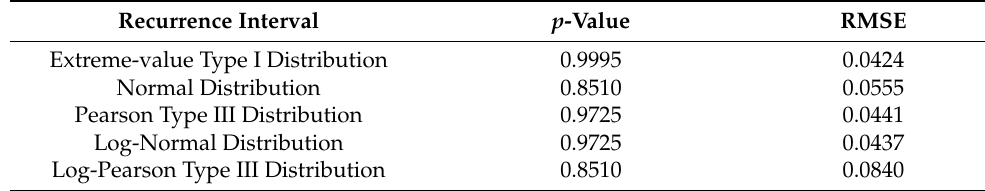
Table 6. Result of KS-Test and RMSE * by